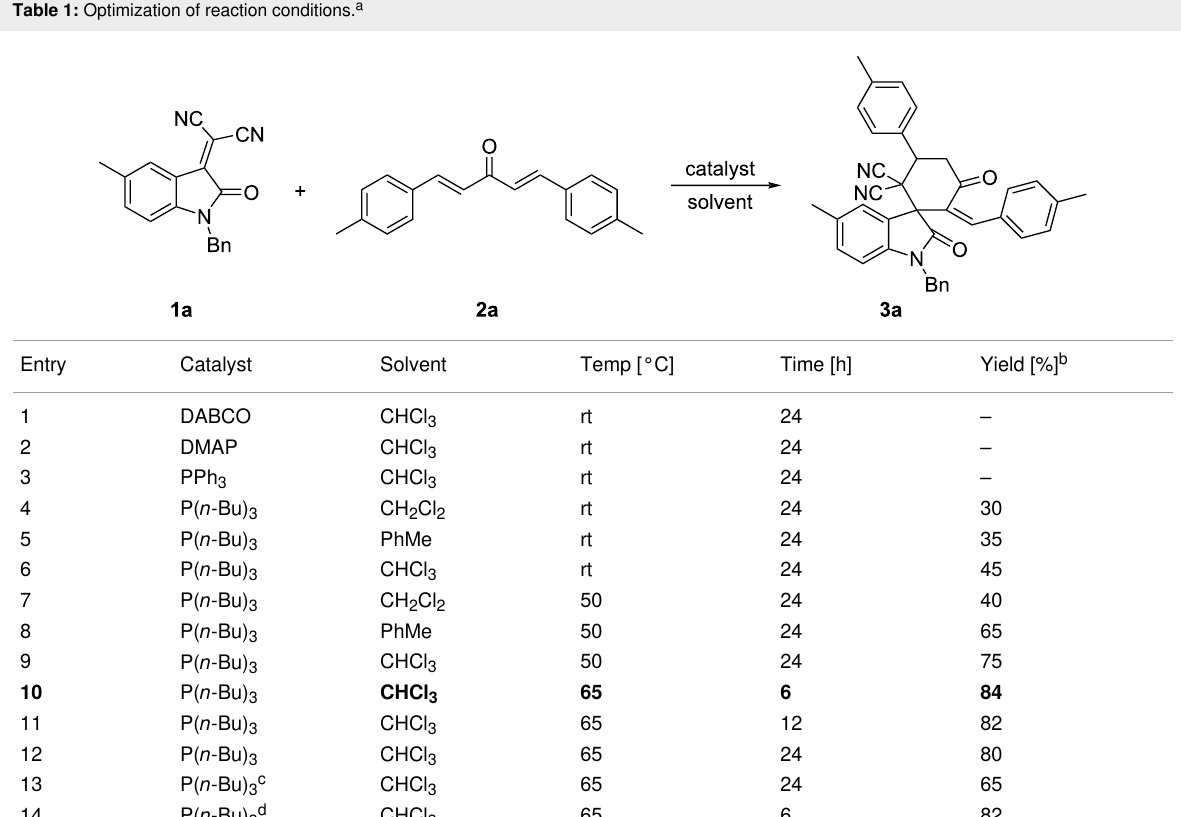
Table 1: Optimization of reaction conditions.